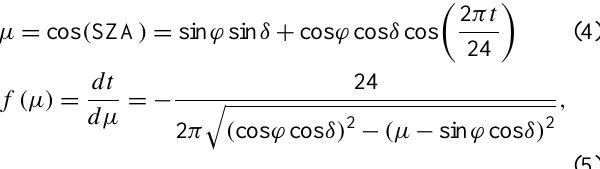
Figure 4. Deep convective cloud radiative forcing at the TOA (left-hand panels) and at the surface (right-hand panels) as a function of solar zenith angle for different ranges of CN concentration (a–c, e–g) and as a function of aerosol CN concentration (d, h) .